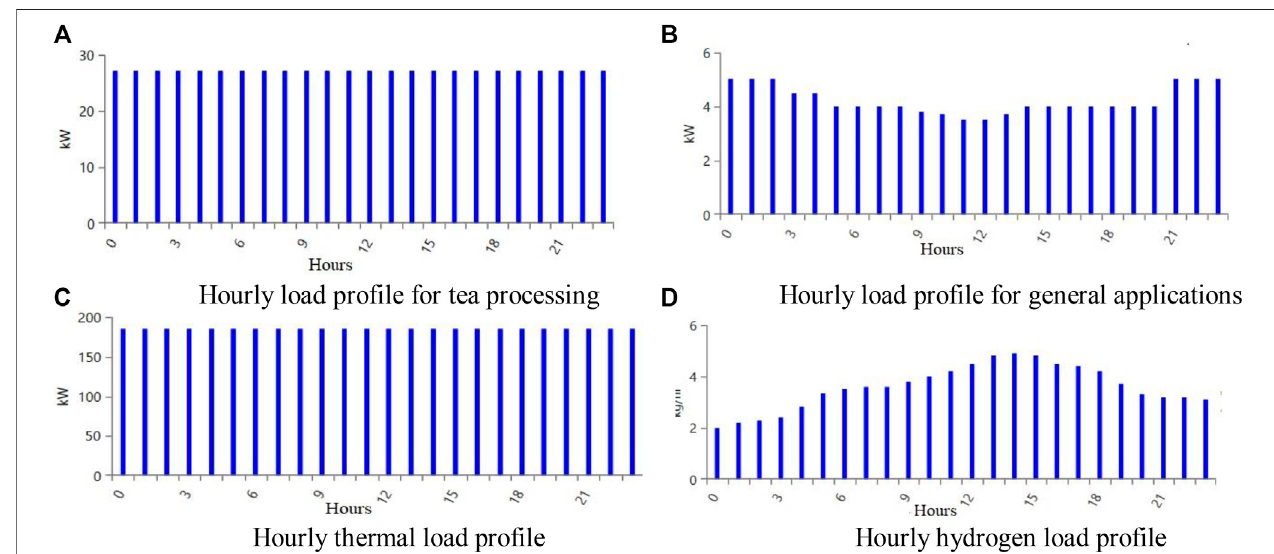
FIGURE 2 | (A) Hourly electrical load pro fi le for tea processing. (B) Hourly electrical load pro fi le for general applications. (C) Hourly thermal load pro fi le. (D) Hourly hydrogen load pro fi